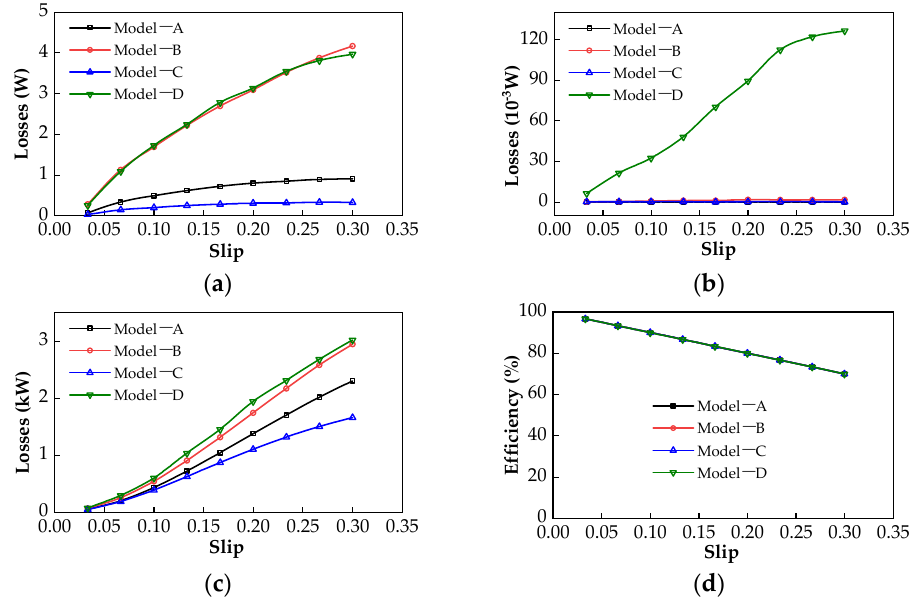
Figure 14. The losses and efficiencies of typical structure PMECCs: ( a ) the core losses of CRs; ( b ) the core losses of PMRs; ( c ) the eddy current losses of CRs; ( d ) efficiency.